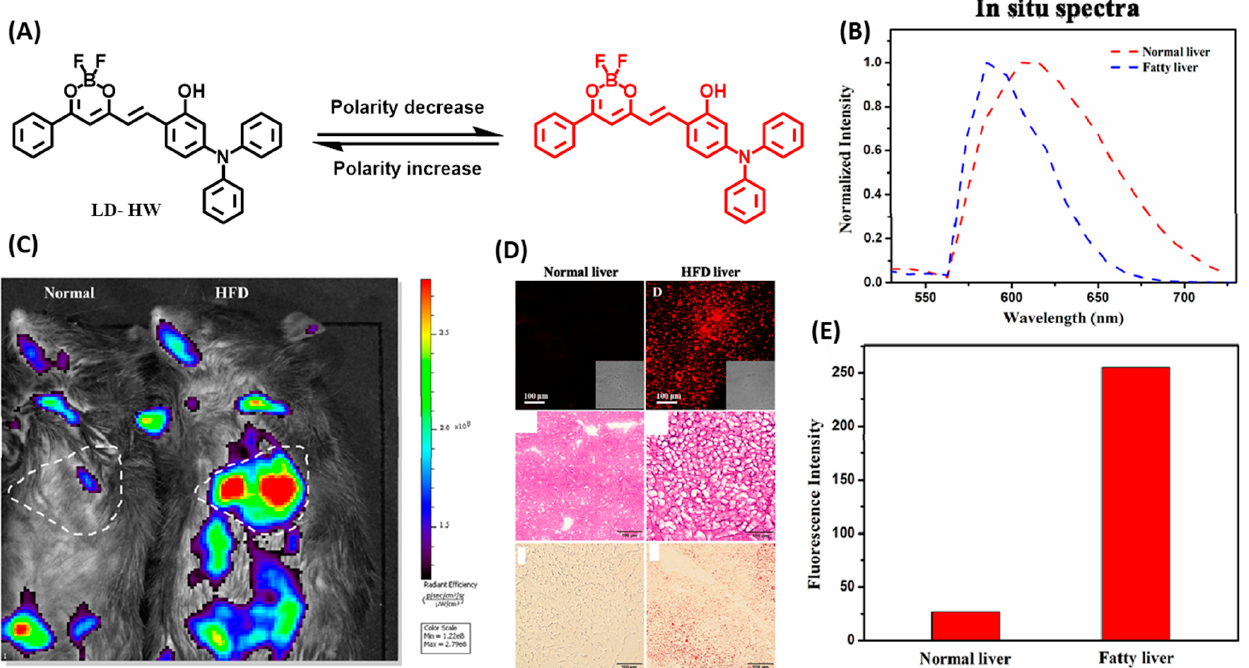
Figure 10. ( A ) Design strategy of the probe LD-HW for visualizing cellular LDs variation. ( B ) In vivo imaging of LD-HW (400 μ L, 300 μ M, through tail vein injection) in normal mice and high-fat diet (HFD) mice, respectively. ( C ) Fluorescence images (Up), H&E stain (Mid), and Oil red O stain (Down) of LD-HW (10 μ M) in normal liver mouse tissues and fatty liver mouse tissues. ( D ) Fluorescence intensity collected from B. ( E ) Normalized in situ fluorescence spectra obtained from B [40].